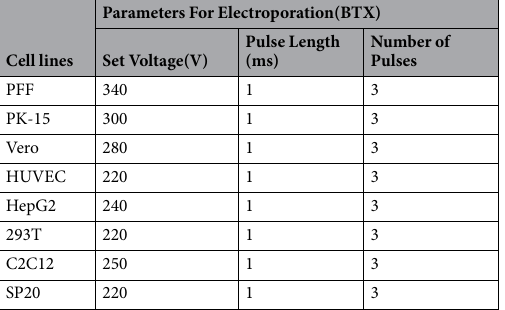
Table 1. Parameters of various cell lines for electroporation